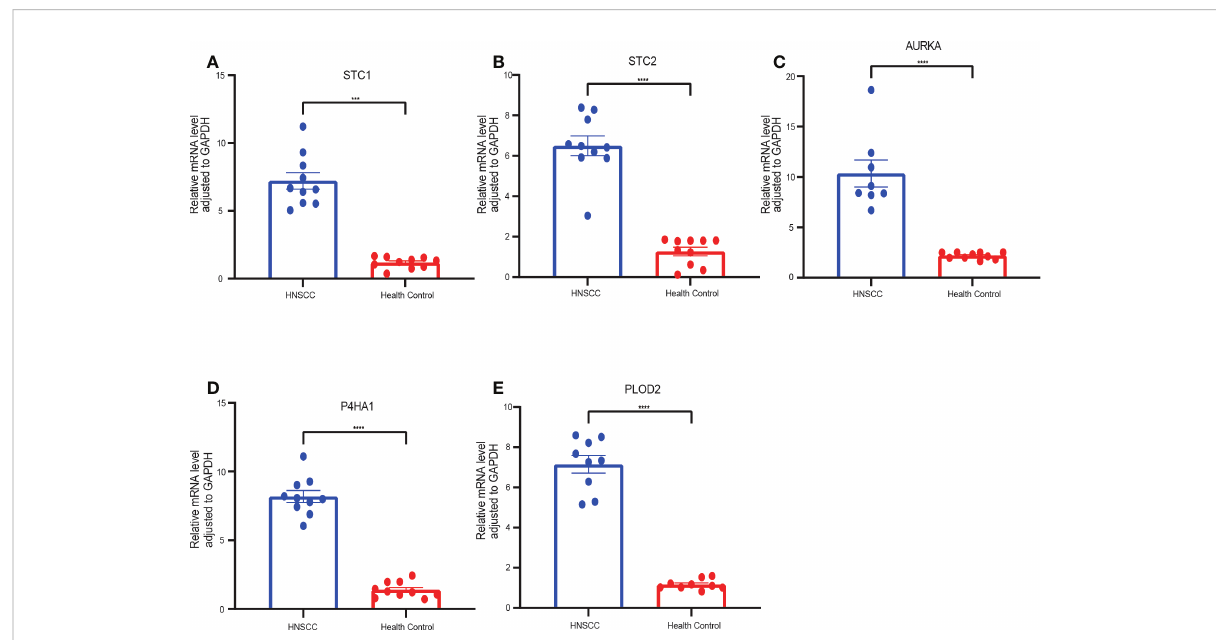
FIGURE 11 RT-qPCR analyses of fi ve hub genes between HNSCC and Healthy control tissues. Relative mRNA expressions of (A) STC1, (B) STC2, (C) AURKA, (D) P4HA1, (E) PLOD2. (***p < 0.001,****p <